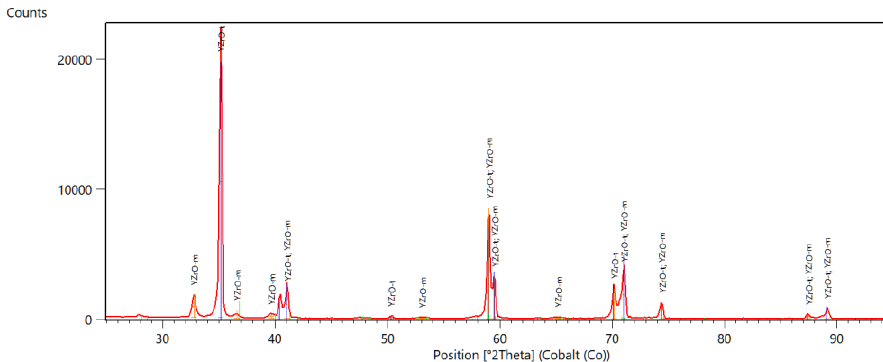
Figure 2. Diffractogram of a ground sample, B.